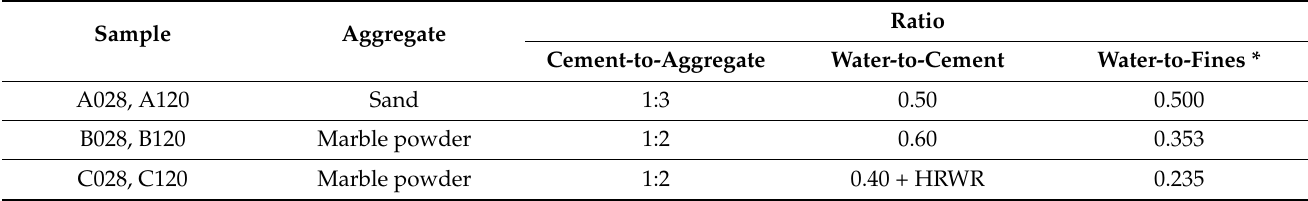
Table 2. Compositions of the